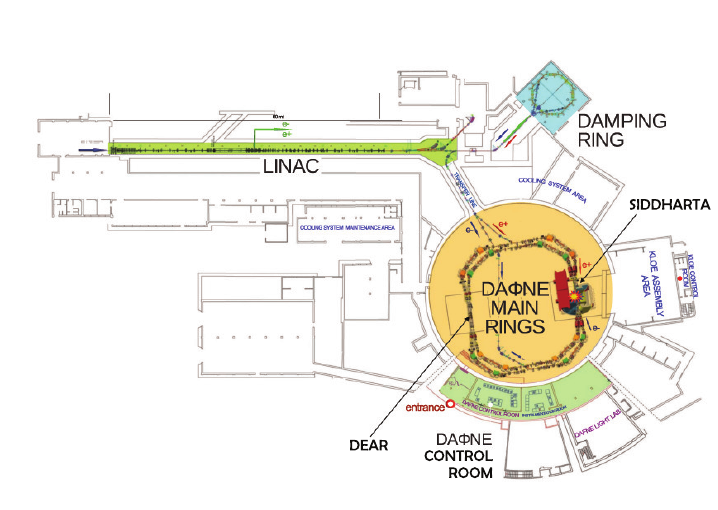
Figure 2: DA Φ NE accelerator complex with marked SIDDHARTA experiment installed in the interaction point. Figure adapted from [ 28 ]